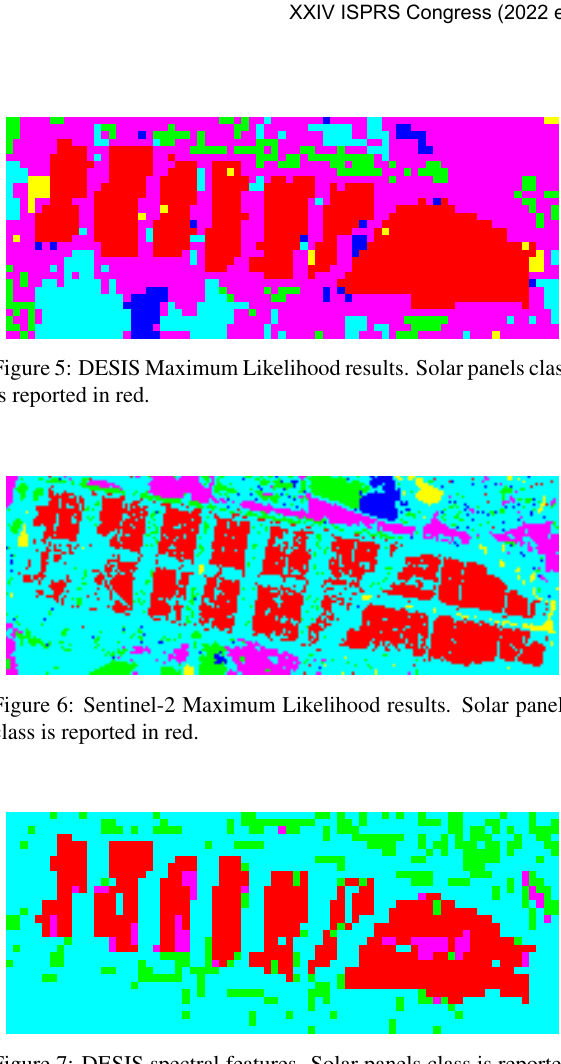
Figure 7: DESIS spectral features. Solar panels class is reported in red.